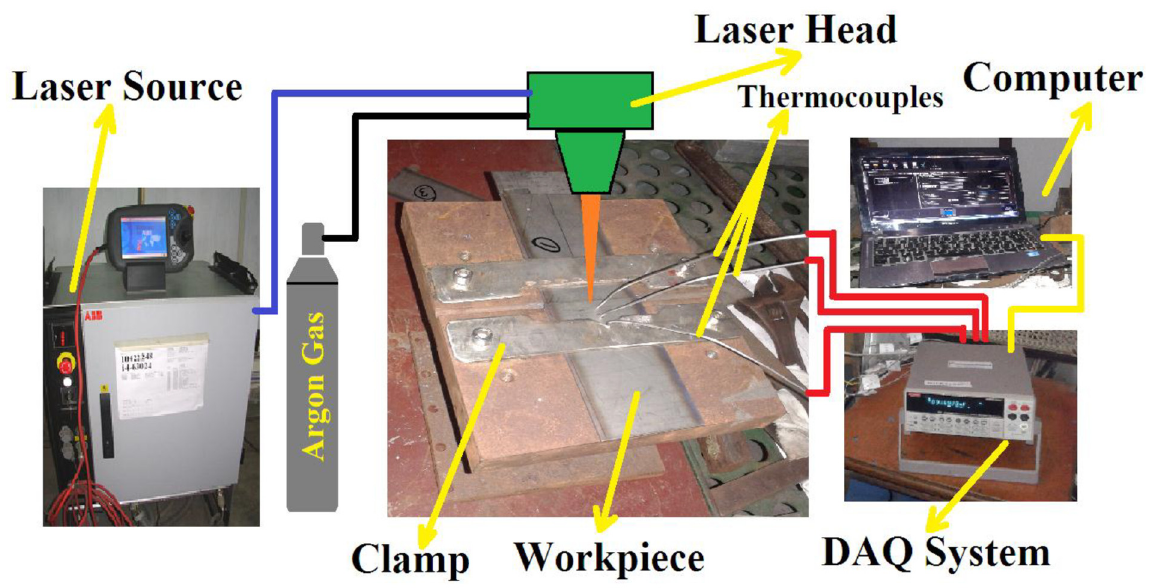
Figure 1. Schematic illustration of the complete experimental setup.